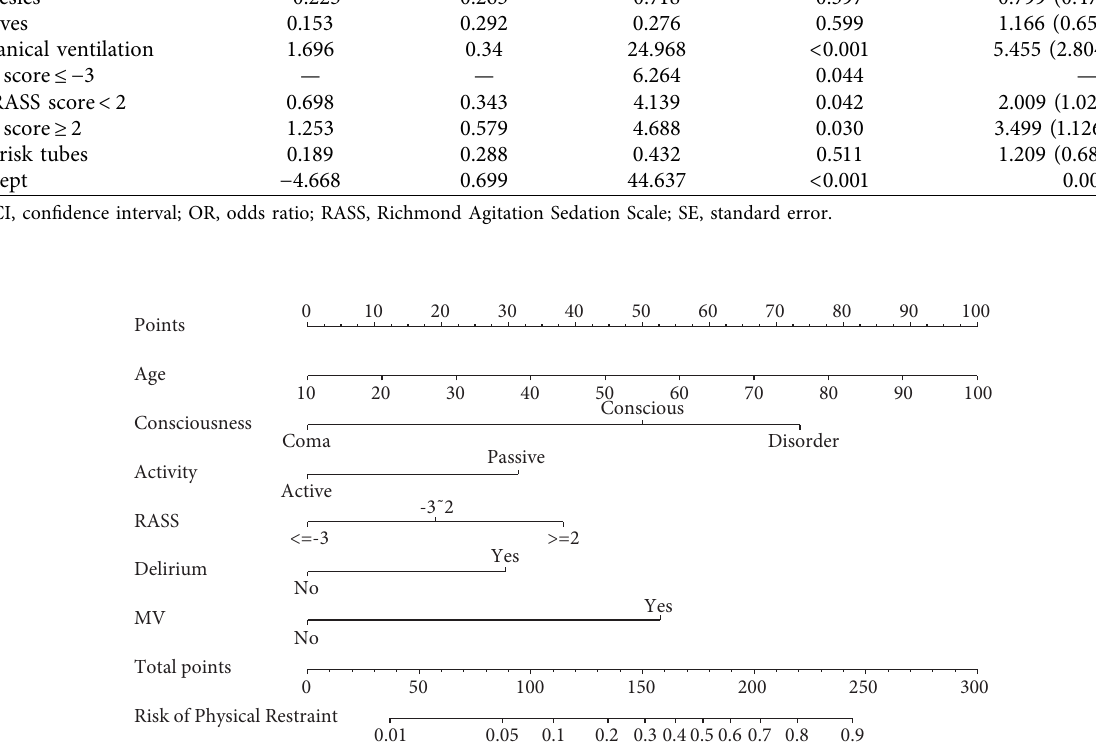
Figure 1: Nomogram predicting the probability of physical restraint in the ICU. To use the nomogram, vertical line was drawn from each variable up to the point. Te resulting value is the patient’s score on that variable (i.e., “delirium � Yes” � 31 points). Te scores for each variable were then summarized to obtain a total score corresponding to the risk of physical restraint. We then plotted a vertical line from the axis of the total point down to the risk of physical restraint, thus obtaining the physical restraint probability for this patient. ICU, intensive care unit; MV, mechanical ventilation; RASS, Richmond Agitation Sedation